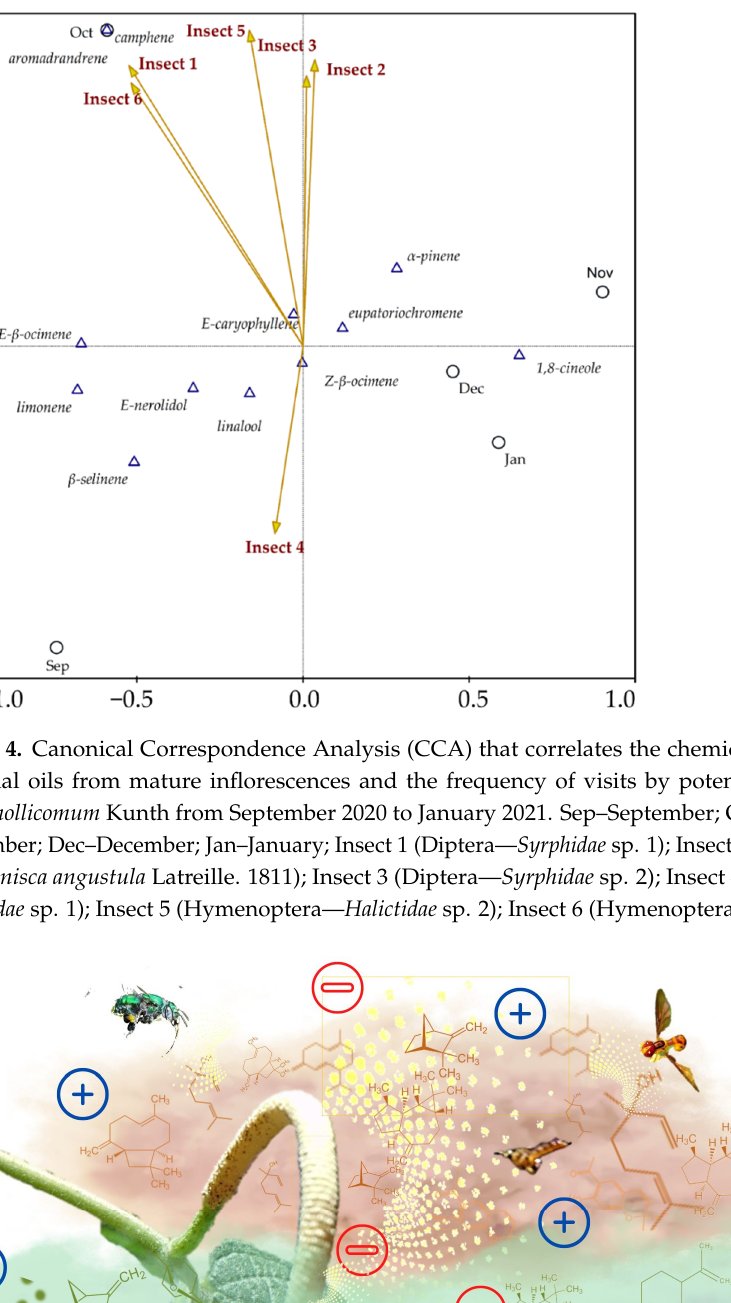
Figure 3. Canonical Correspondence Analysis (CCA) that correlates the chemical composition of foliar essential oils and the frequency of visits of potential pollinators of Piper mollicomum Kunth from September 2020 to January 2021. Sep–September; Oct–October; Nov–November; Dec– December; Jan–January; Insect 1 (Diptera— Syrphidae sp. 1); Insect 2 (Hymenoptera— Tetragonisca angustula Latreille. 1811); Insect 3 (Diptera— Syrphidae sp. 2); Insect 4 (Hymenoptera— Halictidae sp.